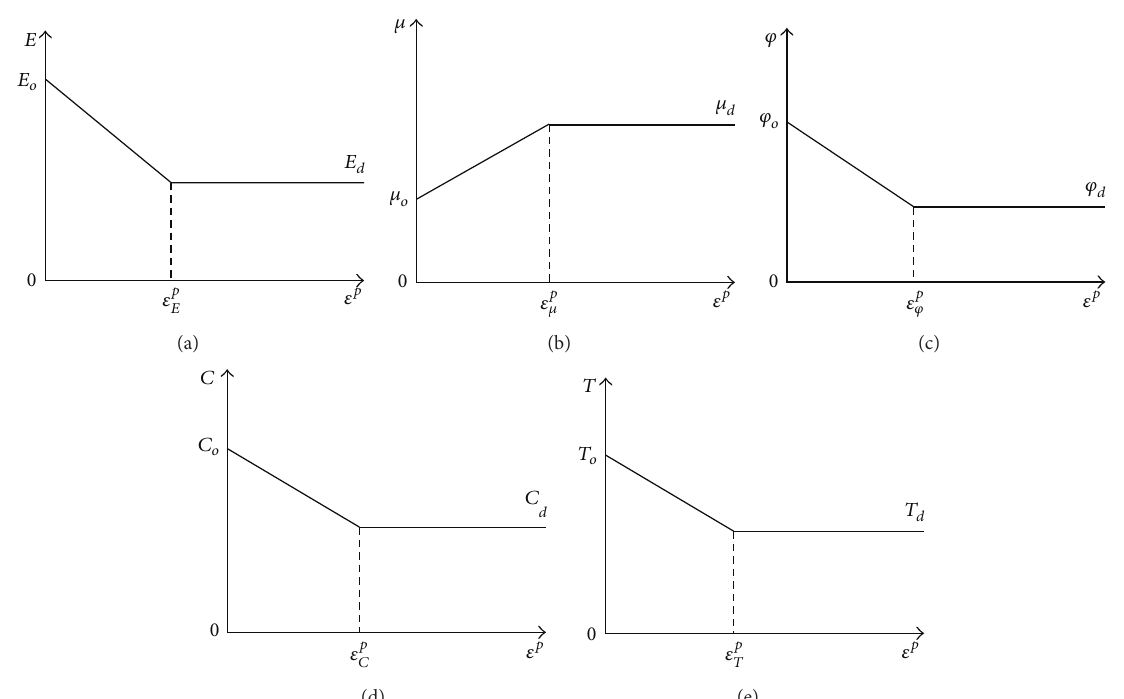
Figure 2: Rock mass mechanical parameters changing curve diagram along with the variation of equivalent plastic